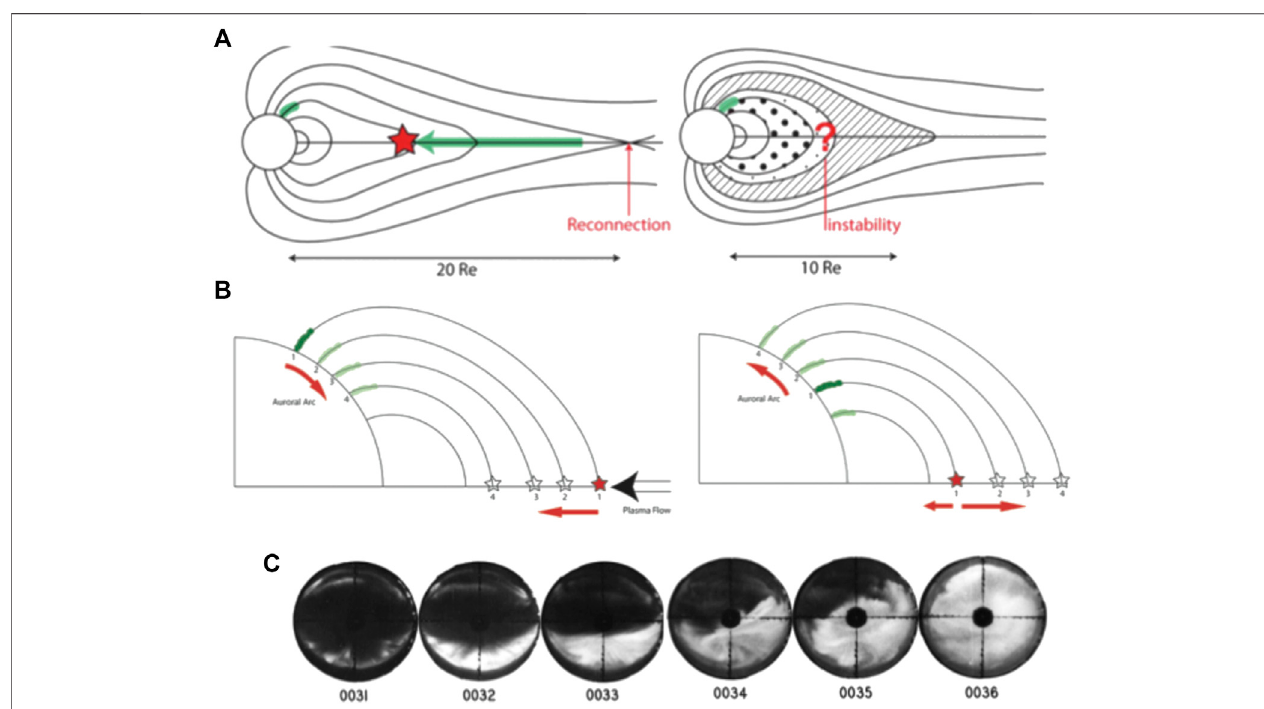
FIGURE 9 | (A, B) Comparison of two ideas of the causes of the expansion phase, in which one considers that the source of auroral substorms is located in the magnetotail (magnetic reconnection) and its effect propagates inward, and the other considers an internal process (instability) in the inner magnetosphere. Magnetic reconnection suggests that auroral activities propagate inward, while a process of internal origin propagates outward. (C) An example of all-sky images of the outward propagation of auroral activities after the initial